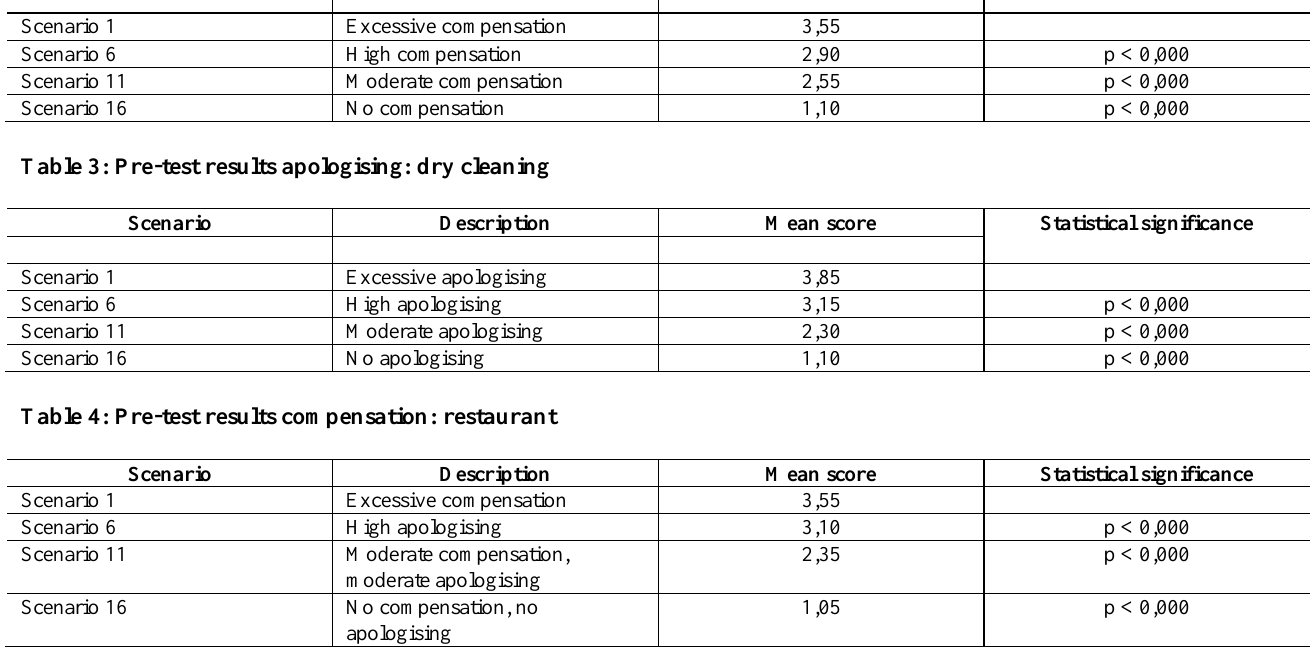
Table 5: Pre-test results apologising: restaurant